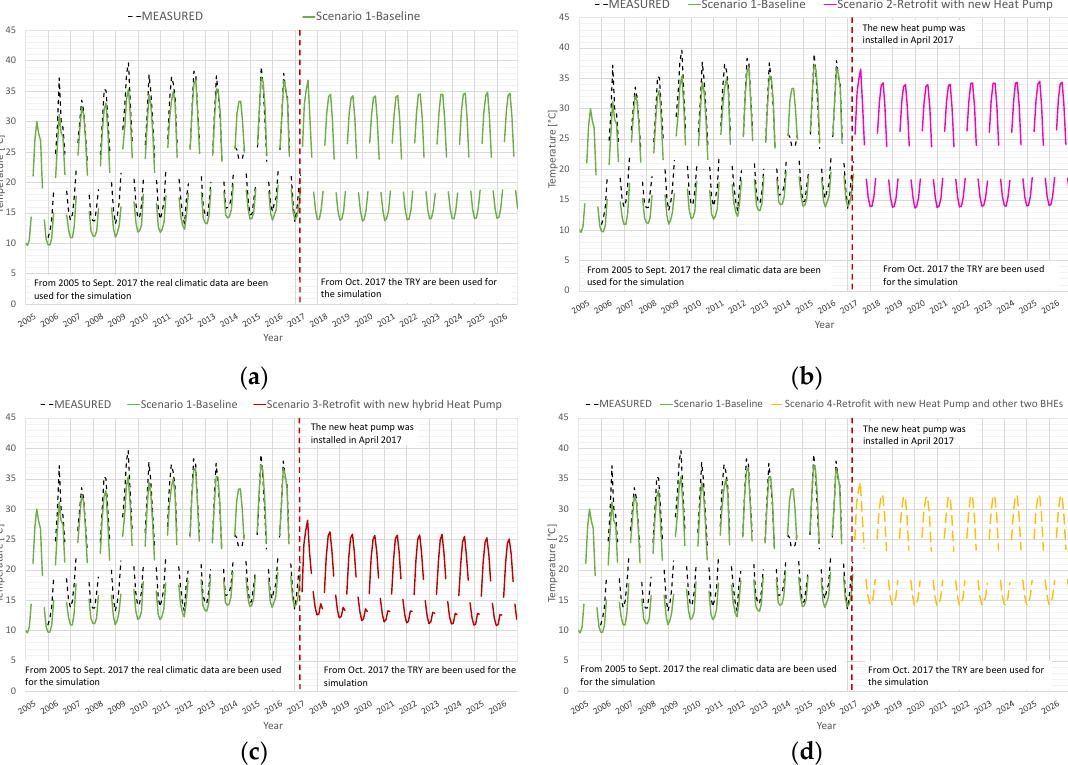
Figure 6. Mean monthly outlet fluid temperature from the borehole heat exchangers: measured values from 2006 to 2017; simulated values in ( a ) Scenario 1 , ( b ) Scenario 2 , ( c ) Scenario 3 , ( d ) Scenario 4 .